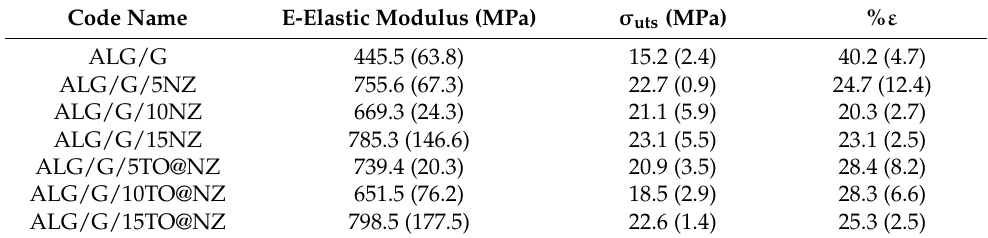
Table 1. Calculated values of Young’s (E) Modulus, ultimate tensile strength ( σ uts ) and % strain at break ( ε b